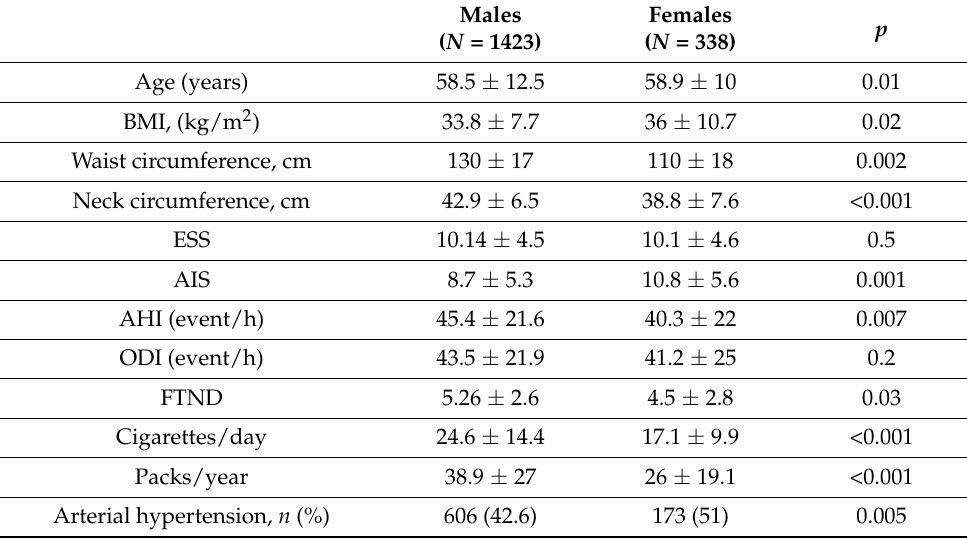
Table 4. Characteristics of ever-smokers OSA patients (AHI ≥ 15) according to